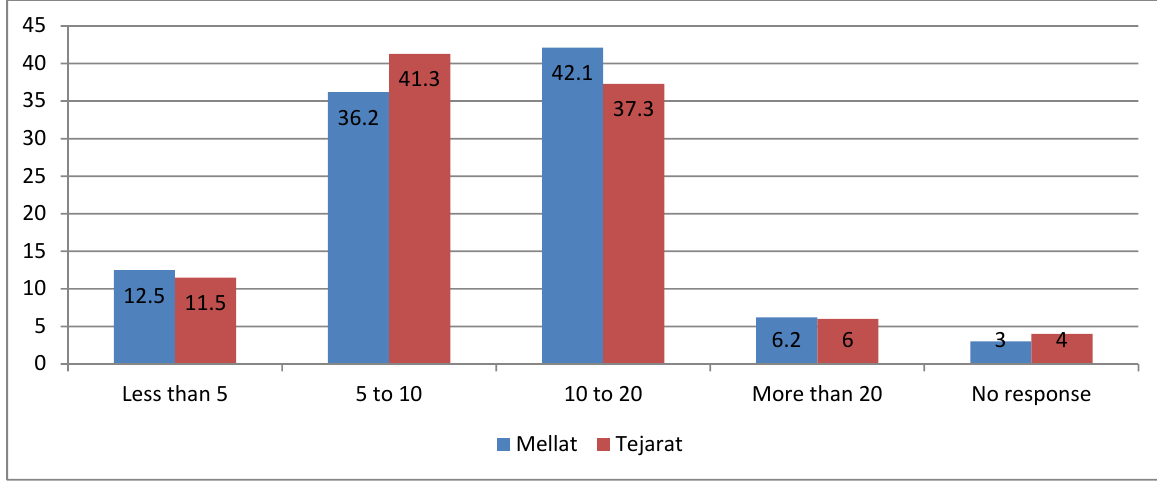
Fig. 3. Frequency of participants’